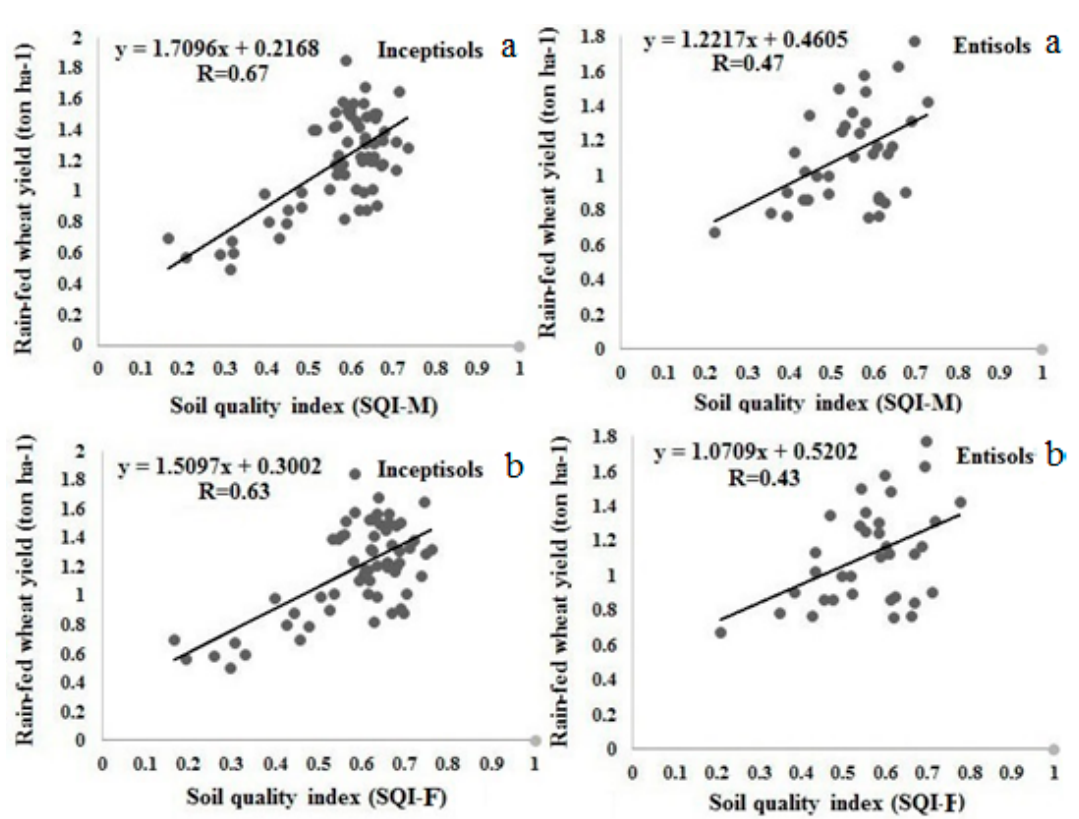
Figure 5. Linear relationship between calculated SQIs using two weighting methods ( a : SQIw-M; b : SQIw-F) and rainfed wheat yield for two soil orders.